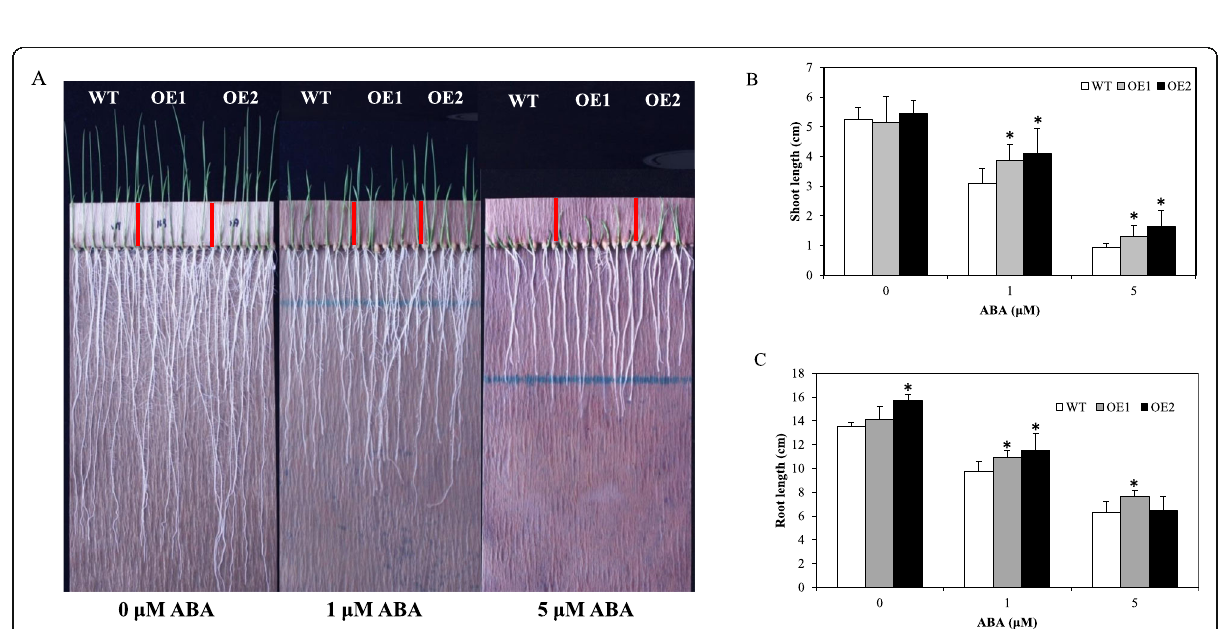
Fig. 7 Sensitivity of the OE plants to ABA. The phenotypes ( a ), shoot lengths ( b ) and root lengths ( c ) of WT and OE lines grown in germination bags under different concentrations of ABA. Each column are means ±SD ( n = 20. * indicates significant difference at P <0.05 based on Dunnett ’ s multiple comparison tests in